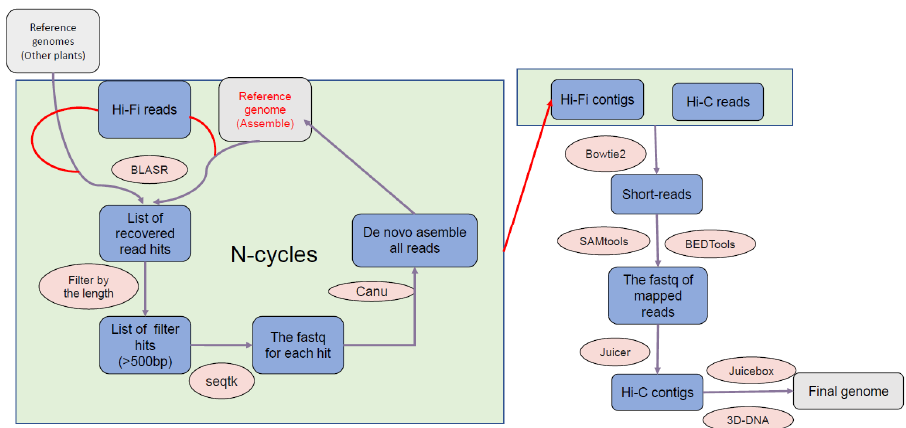
Figure 1. Flowchart of C. gigantocarpa mitochondrial genome assembly.